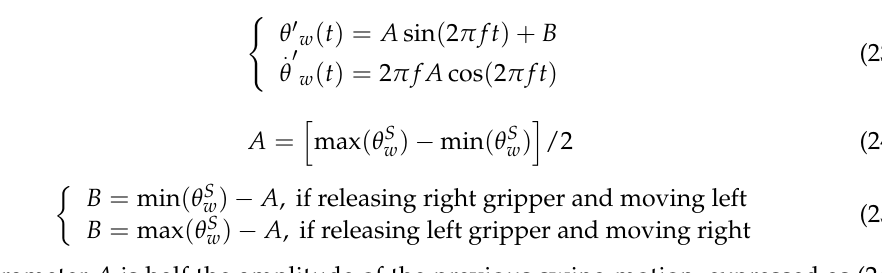
There is an inherent delay between the time that a command is sent and the time at which the gripper responds, and the grasping action cannot be completed after the support gripper passes beyond the target ledge. The primary objective here is to complete the grasping action within a short time window (i.e., without missing the target ledge), while maintaining a posture suitable for grasping. We sought to resolve this problem by sending grasping commands slightly before the anticipated arrival time.